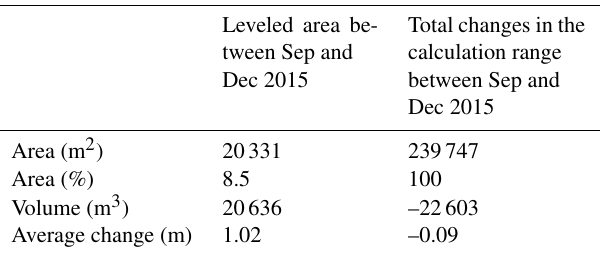
Table 4. Results of the volumetric calculations (changes